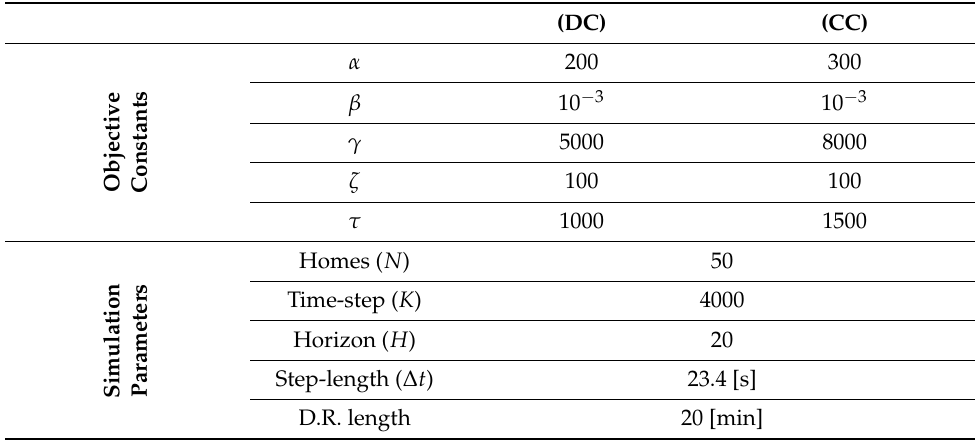
Table A2. Simulation parameters of decentralized (DC) and centralized (CC)